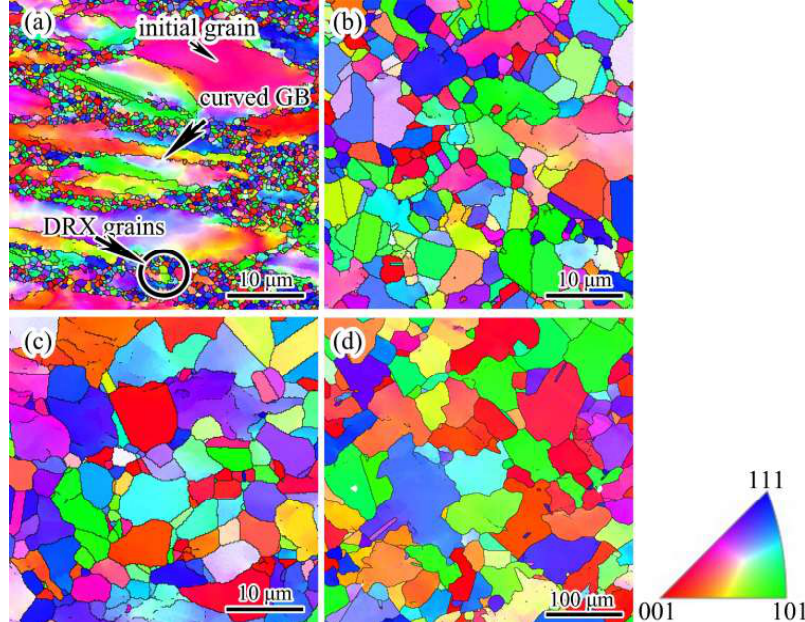
Figure 7. Grain orientation maps of GH4169 alloy compressed at ( a ) 950 °C, 1 s −1 , 0.9; ( b ) 1100 °C, 1 s −1 , 0.9; ( c ) 950 °C, 0.001 s −1 , 0.9; and ( d ) 1100 °C, 0.001 s −1 , 0.9. The large angel grain boundaries (≥15°) were shown as black lines. Note that the ruler length of ( d ) was different from the others. GB and DRX were abbreviations of “grain boundary” and “dynamic recrystallization”, respectively.